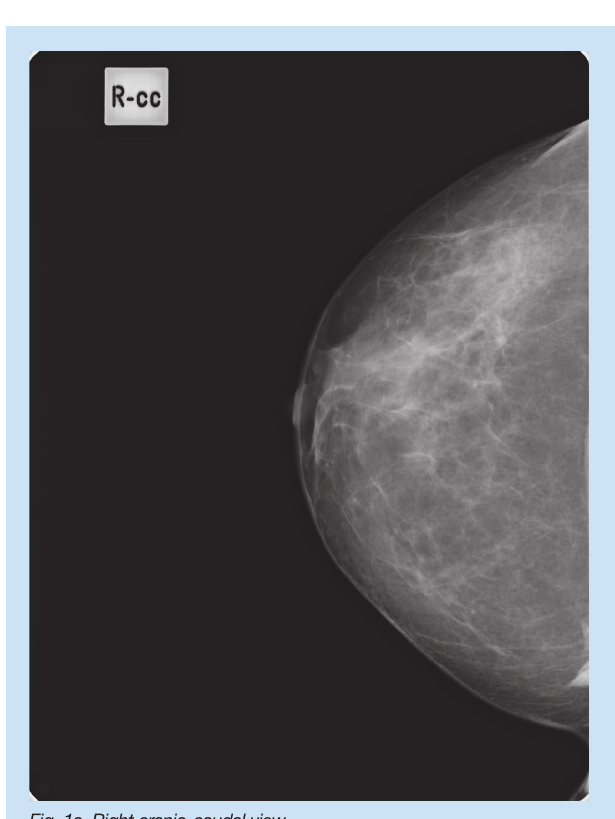
Fig. 1a. Right cranio-caudal view.